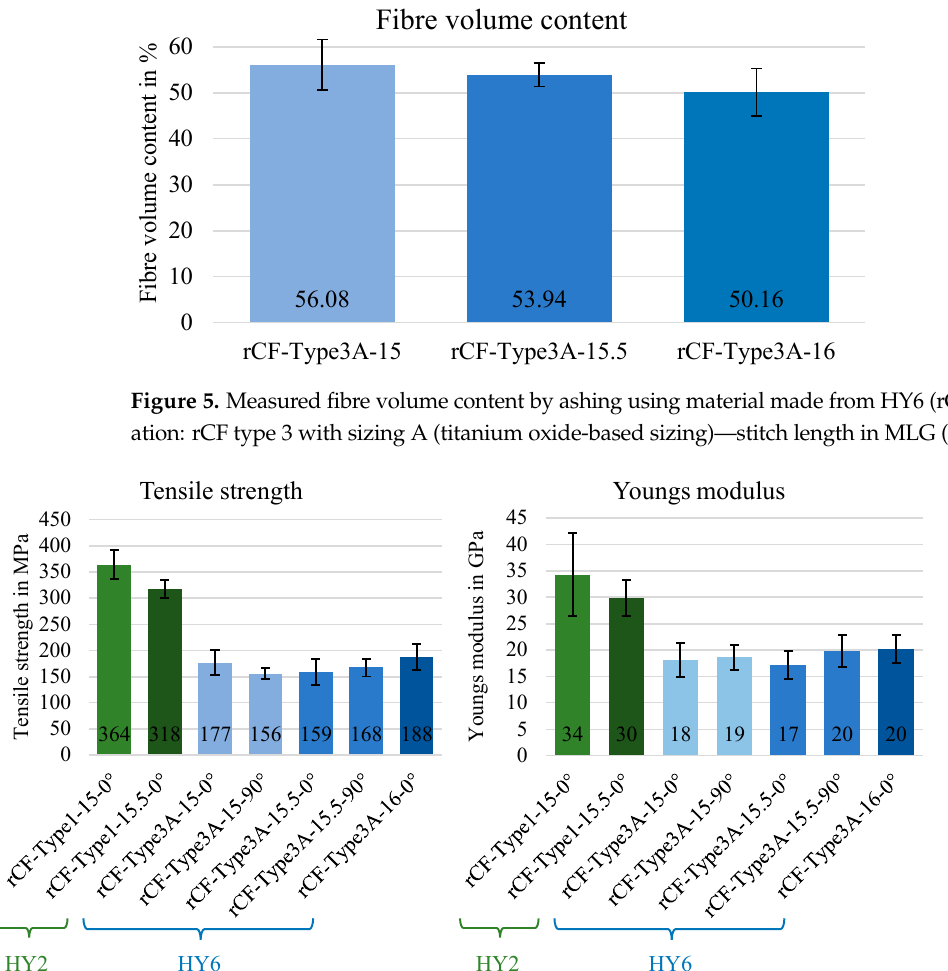
Figure 6. Tensile strength and Young’s modulus (DIN EN ISO 527-4) of rCFRP made of an rCF multi-layer weft knitted fabric. Indexation: rCF type in hybrid yarn (green: rCF-Type 1, blue: rCF-Type 3); HY—stitch length in MLG (15/15.5/16 mm)—test direction (0° warp/90° weft).